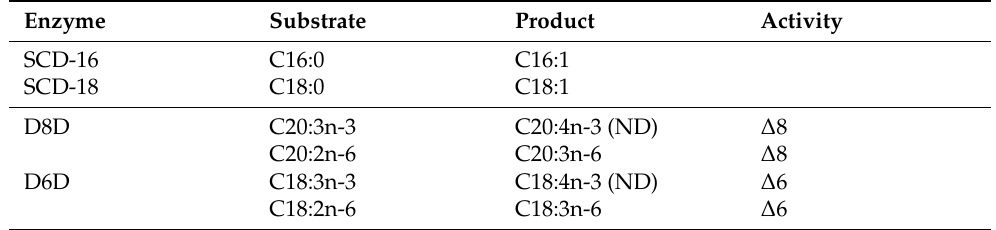
Figure 4. Markers of desaturase and elongase indices associated with malnutrition status at both time points. Enzyme activity indices estimated by fatty acid ratios in Pakistani undernourished children and healthy controls at age 3–6 months ( A ) and 9 months ( B ). Fatty acid unit of measurement expressed as µg/mL of serum. Bars and error bars represent mean and ± SEM. To compare mean ratio markers between undernourished children and healthy controls, t − test was used. * p < 0.05, ** p < 0.01, *** p < 0.001, **** p < 0.0001. SCD-18, stearoyl − CoA desaturase − 18; D8D, delta − 8 − desaturase; D4D, delta − 4-desaturase; ELOVL5, elongase 5. Table 2. Substrates and products of elongases and desaturases investigated in the study. Enzyme Substrate Product Activity